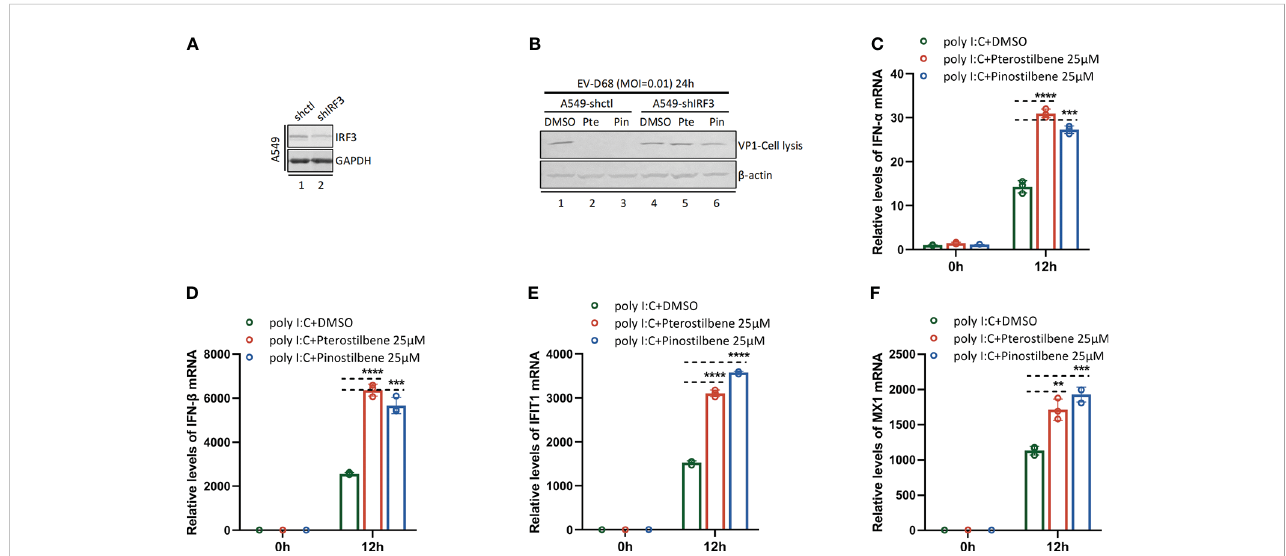
FIGURE 7 Pterostilbene (Pte) and pinostilbene (Pin) mediate innate immune activation through IRF3 signaling pathway. (A) IRF3 gene knock-down ef fi ciency validation by Immunoblotting. (B) A549-shctl or A549-shIRF3 cells were pre-treated with Pte (25 µM), Pin (25 µM) or 0.1% DMSO for 2h and then infected with EV-D68 at an MOI of 0.01. Cells were collected 24 h post-infection. Viral protein VP1 was detected using Immunoblotting. (C – F) , A549 cells were pre-treated with Pte, Pin or DMSO for 2h, then transfected with Poly I:C (1 µg per well). Cells were collected at 0h and 12h post-transfection. Relative intracellular IFN- a , IFN- b , MX1 and IFIT1 mRNA were detected using qRT-PCR. Error bars indicate the standard deviation (**, P < 0.01; ***, P < 0.001; ****, P < 0.0001).